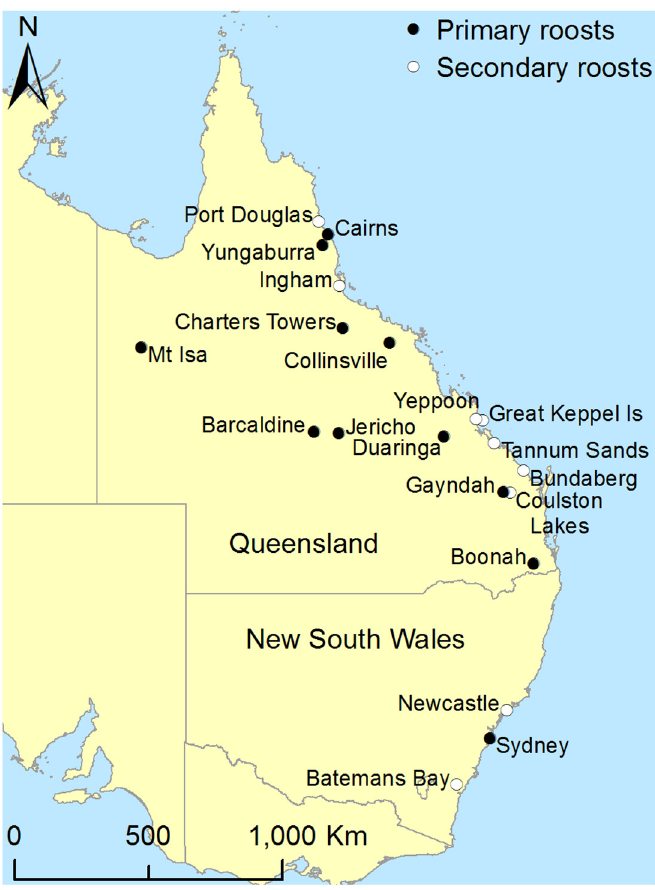
Fig 1. Eleven primary roosts and ten secondary roosts monitored in the eastern Australian states of Queensland and New South Wales between September 2011 and November 2012. [Sydney has two roosts — Sydney Royal Botanic Gardens (RBG), a primary roost, and Sydney Centennial Park (CP), a secondary roost. The former is